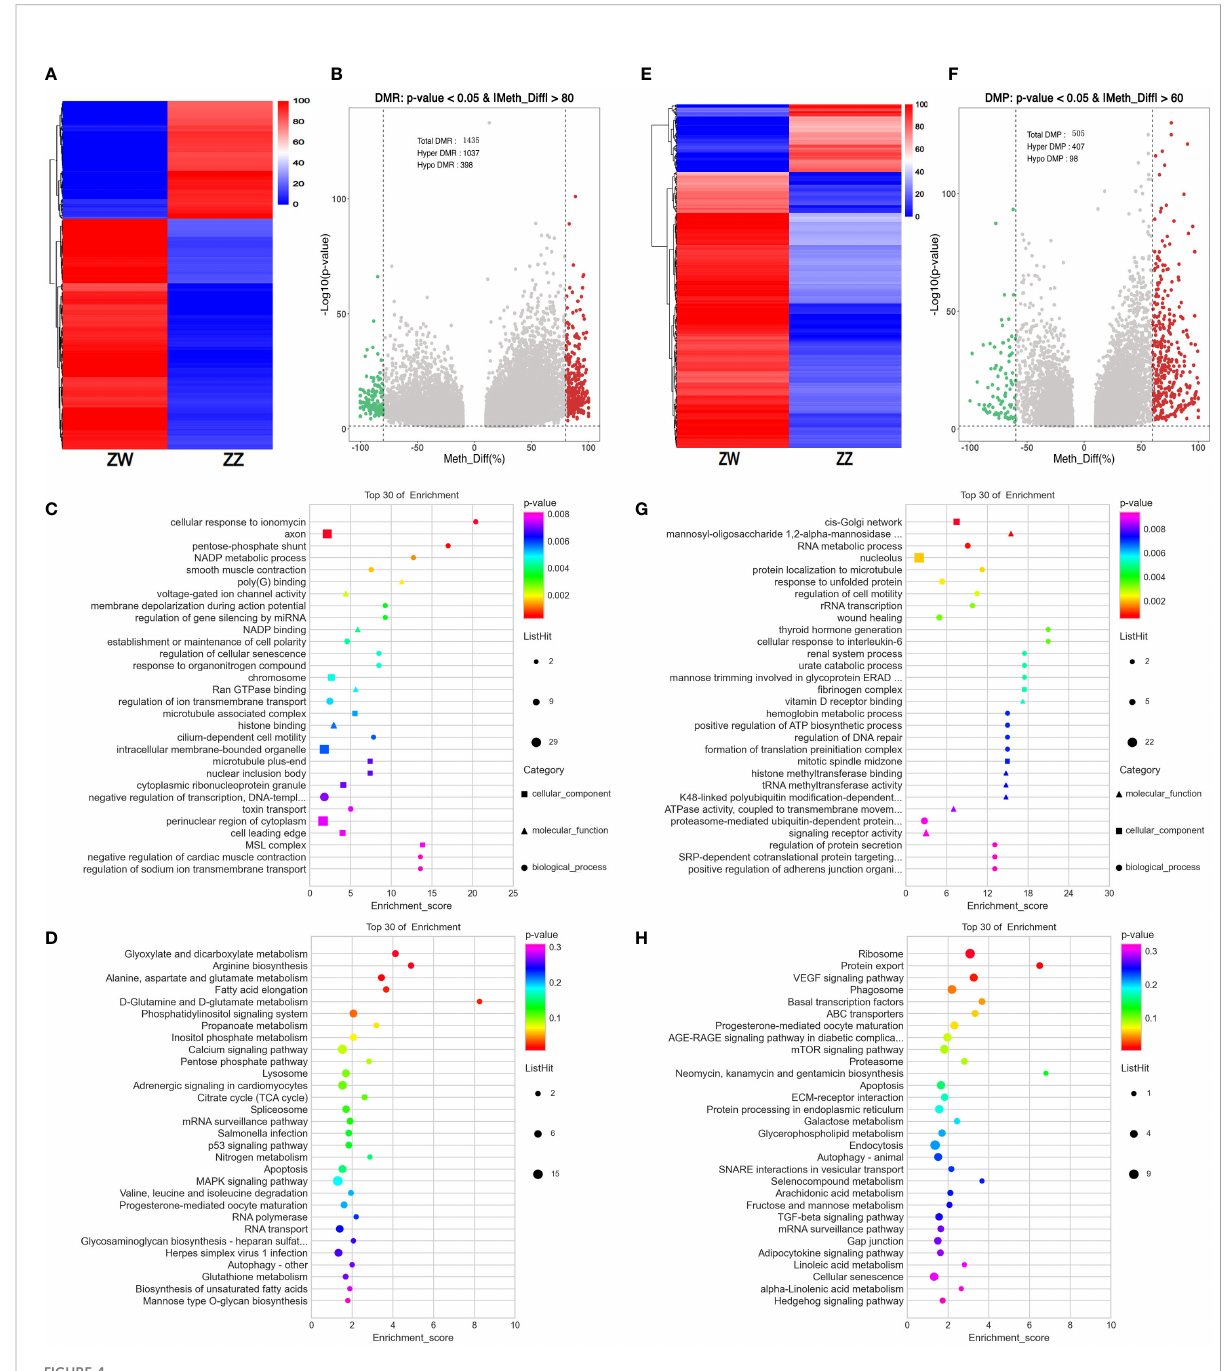
FIGURE 4 DMRs/DMPs feature and functional annotation analysis. (A) Heatmap of DMRs (on level of |methyl differs| > 0.8 & p value < 0.05) between ZW and ZZ groups showed the degree of differential methylation. (B) Volcano map of DMRs (on level of |methyl differs |. > 0.8 & p value < 0.05) between ZW and ZZ groups. Red dots represent hypermethylation and green dots represent hypomethylation (C) GO enrichment of Top 30 GO term of DMRs between ZW and ZZ groups (D) KEGG pathways enrichment of Top 30 KEGG pathways of DMRs between ZW and ZZ groups (E) Heatmap of DMPs (on level of |methyl differs |. > 0.6 & p value < 0.05) between ZW and ZZ groups showed the degree of differential methylation. (F) Volcano map of DMPs (on level of |methyl differs |. > 0.6 & p value < 0.05) between ZW and ZZ groups. Red dots represent hypermethylation and green dots represent hypomethylation (G) GO enrichment of Top 30 GO term of DMPs between ZW and ZZ groups (H) KEGG pathways enrichment of Top 30 KEGG pathways of DMPs between ZW and ZZ